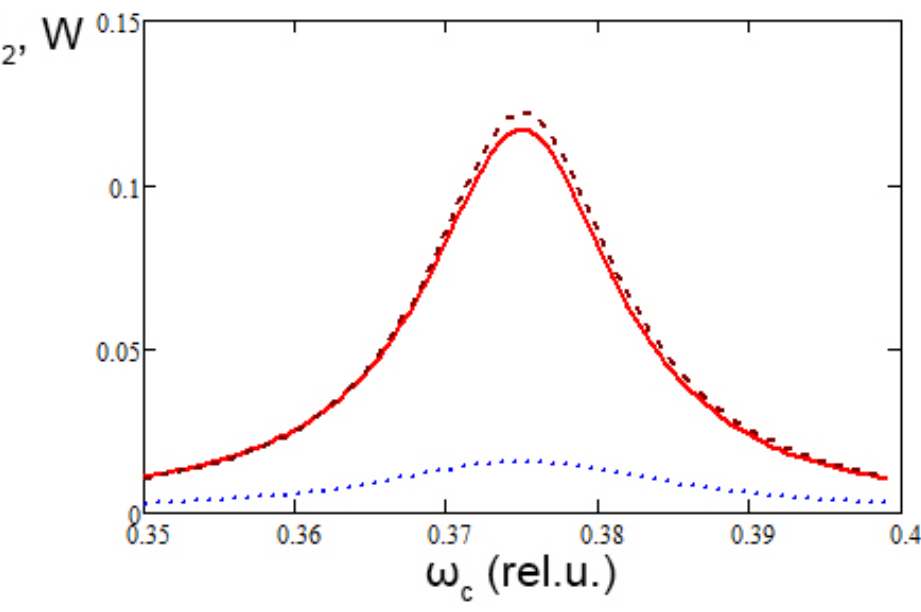
Figure 3. Short pulses τ < T 2, weak saturation s = 0.56 ( τ = 150, T 2 = 10 3 , Ω 0 = 0.005): solid line—Bloch equation solution, dotted line—generalized Karplus–Schwinger approach, dashed line—Lorentz profile neglecting saturation.